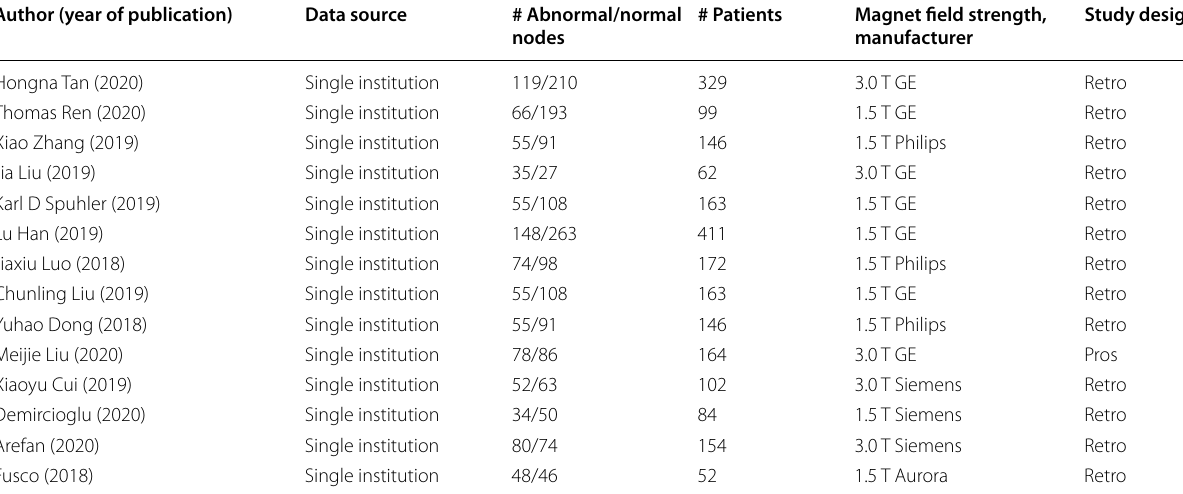
Table 1 Study and patient